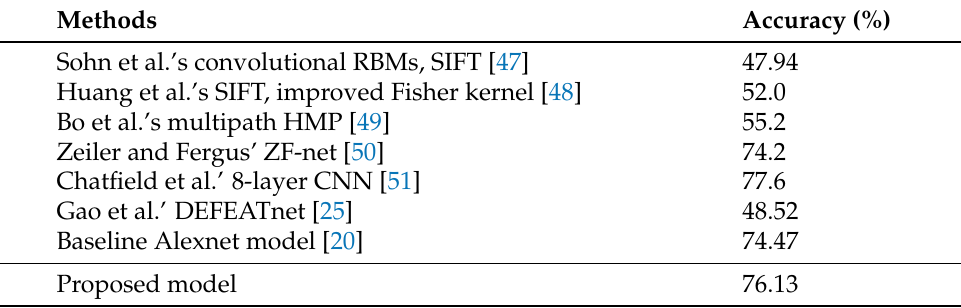
Table 3. Comparison of classification accuracy on Caltech-256.